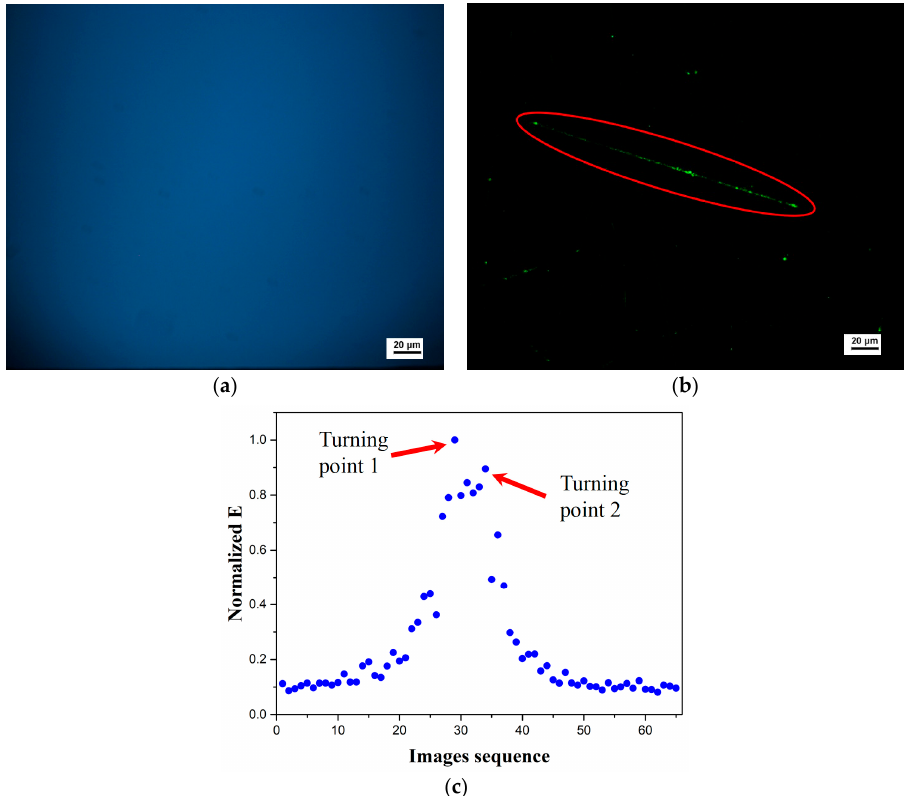
Figure 9. Images of subsurface damage for sample #2. ( a ) Image under bright field; ( b ) Image under total internal reflection illumination; ( c ) Definition curve of the crack.